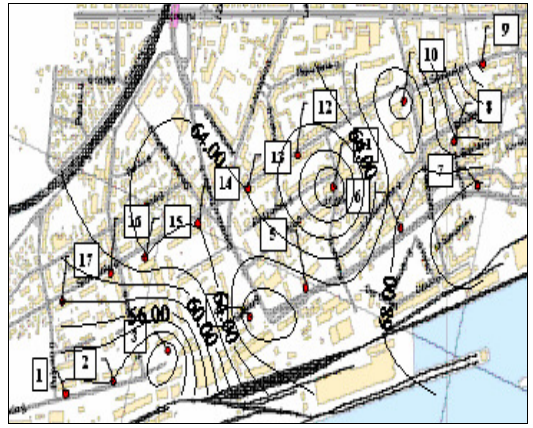
Fig. 8. Noise spread in the northern part of Klaipėda city in the evening in autumn